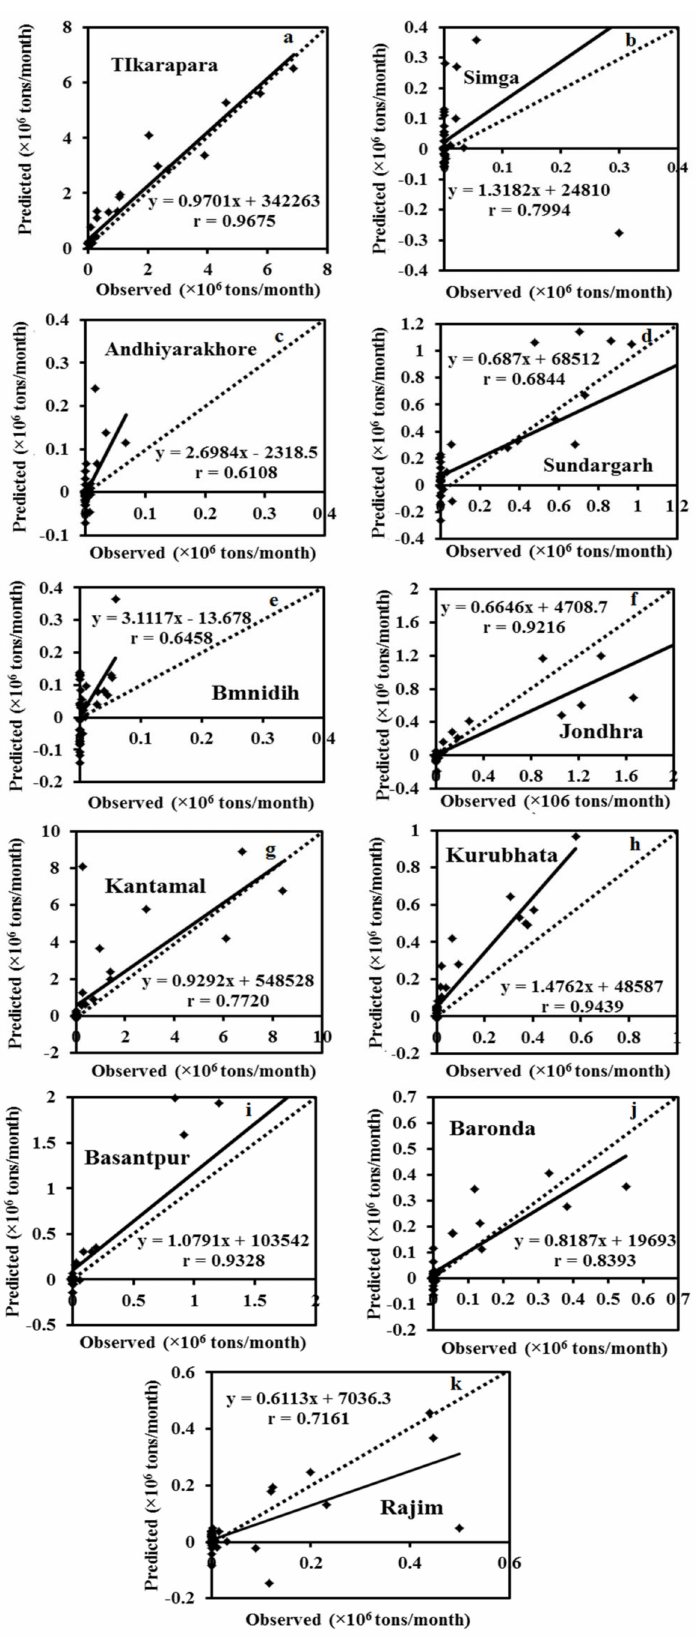
Figure 8. Scatter plots between predicted SSY and actual SSY of testing data of the ANN prediction